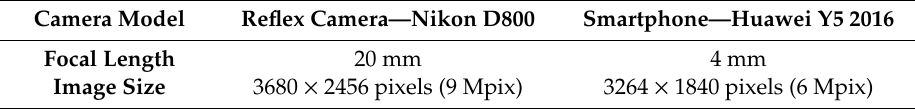
Table 1. Characteristics of the images taken by the Reflex camera and the Smartphone camera.